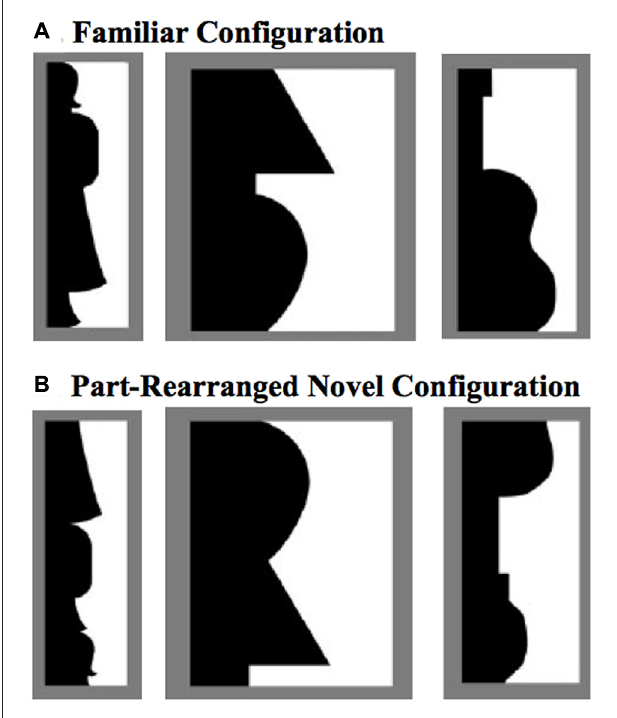
FIGURE 1 | Example stimuli used to test effects of familiarity on object perception (Peterson and Gibson, 1994; Peterson et al., 1998, 2000). (A) Familiar Configurations (composed of familiar parts), with the critical region (black here) depicting (from left to right) a standing woman, a lamp, and a guitar. (B) The black regions depict Part-Rearranged Novel Configurations , composed of the same familiar parts as the objects in (A) , but here they are spatially rearranged so that the configuration is novel. The critical regions here are shown in black and on the left, but color and side were counterbalanced in the experiment.